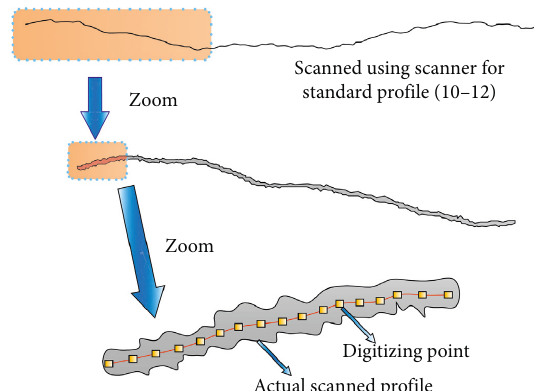
Figure 5: The diagram used to show digitization of a joint profile